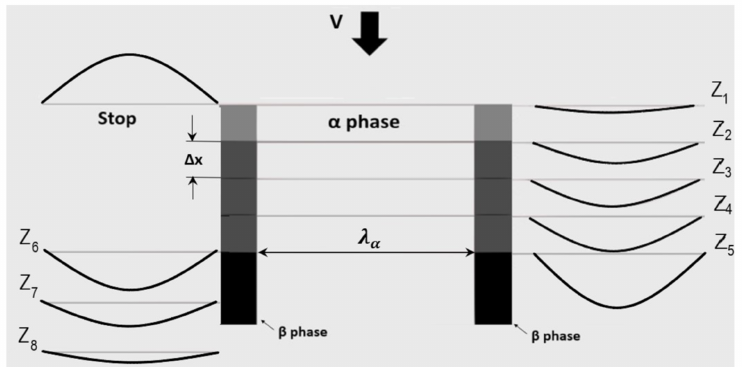
Figure 2. Schematic view of the growth of a single cell during DD with accompanying solute concentration profiles in the go- and -stop period for Cahn’s parameter C = 7.23 and x* = 16 at.% Zn. v DD = 0.5 nm/s, λ α = 150